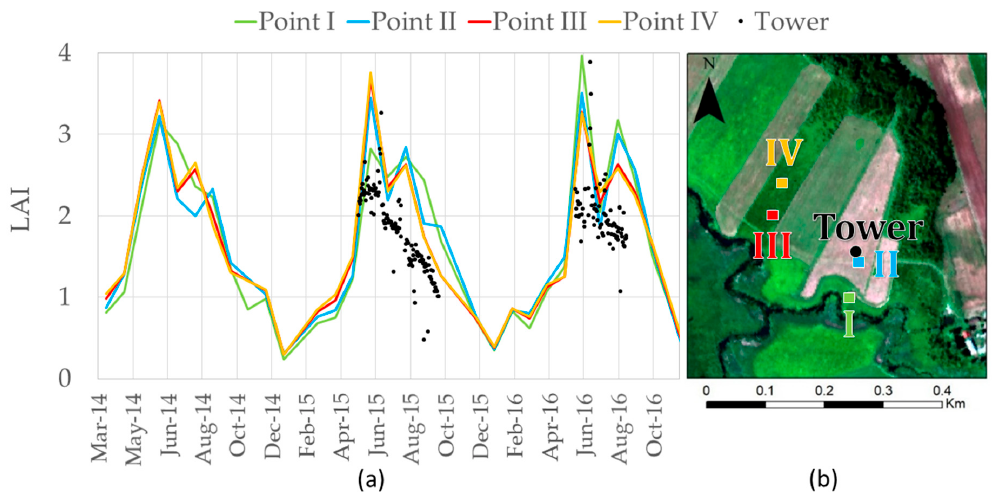
Figure 5. Comparison between the Tower data and Vegetation dynamics ( a ) captured with Proba-V and processed with TREX analyzed for 4 points ( b ) (from March 2014 until December 2016). Points I,II are representing wet meadows and III,IV meadows encroached by trees.